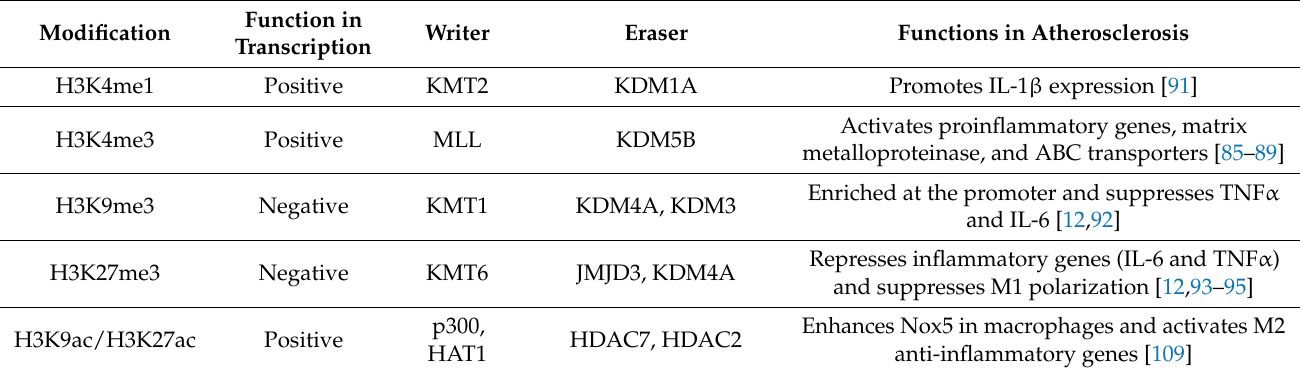
Table 1. Histone modifications and their functions in monocytes and macrophages during